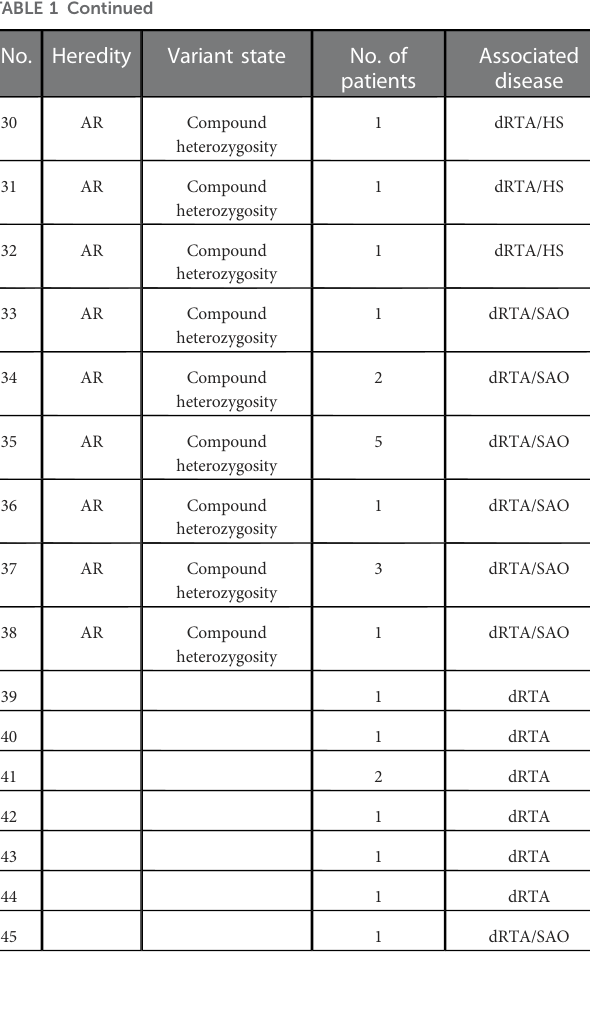
Hypokalemia was seen in 72 (72/109, 66.06%) patients, and the mean of serum potassium in 109 patients was 3.16 mmol/L. Hyperchloremia was seen in 50 (50/53, 94.34%) patients, and the mean of serum potassium in 109 patients was 113.02 mmol/L. The comparisons of biochemical indexes and age of onset between AD and AR SLC4A1 -dRTA are shown in Figure 4 . The age of onset was younger ( P < 0.01), alkaline urine was more severe ( P < 0.01), and serum potassium was lower ( P < 0.001) in recessive patients than patients with dominant SLC4A1 mutations. Among 61 patients with AR dRTA, hematological abnormalities were observed in 30 (30/61,49.18%) patients, and most of them were from Southeast Asia. However, only 11(10.89%) patients presented with hematological abnormalities in 101 patients with AD dRTA. The comparisons of biochemical indexes and age of onset between Asian and Non-Asian patients are shown in Figure 5 . The age of onset was younger ( P < 0.01), alkaline urine was more severe ( P < 0.001), and serum potassium was lower ( P < 0.01) in Asian patients than Non-Asian patients. There are no differences in biochemical indexes and age of onset between male and female ( P > 0.05). As shown in Figure 6 , the recessive forms of dRTA often involves other organs than the kidney, incluing developmental disorders, hematological abnormalities ( P < 0.001) and gastrointestinal symptoms ( P <